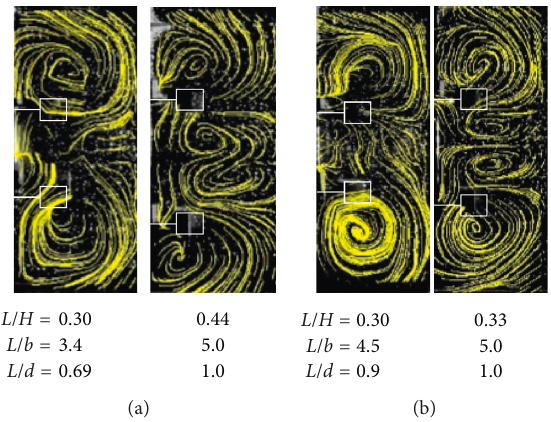
Figure 5: Effect of liquid depth on flow between impellers at Re �